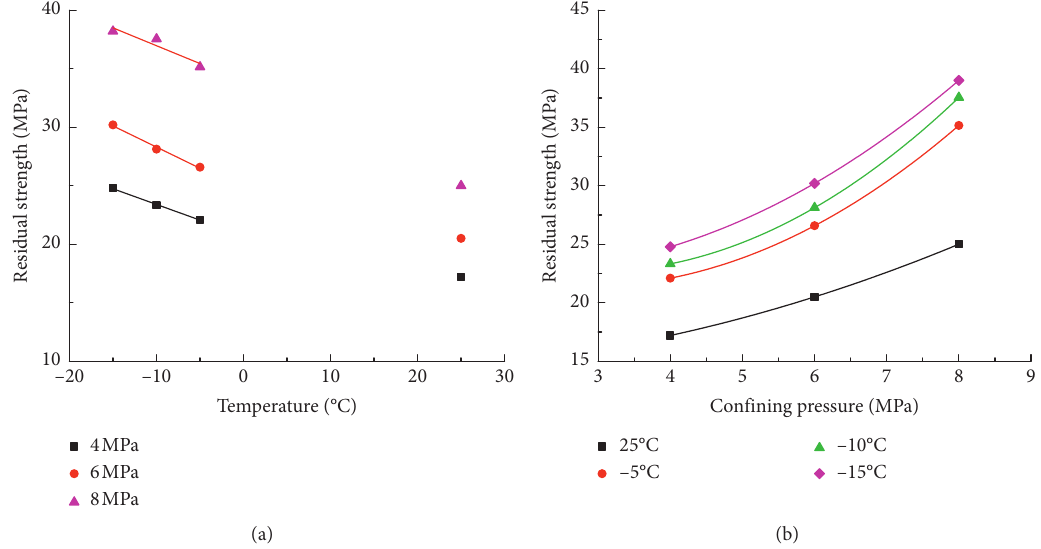
Figure 7: Residual strength curves under different conditions: (a) temperature and (b) confining